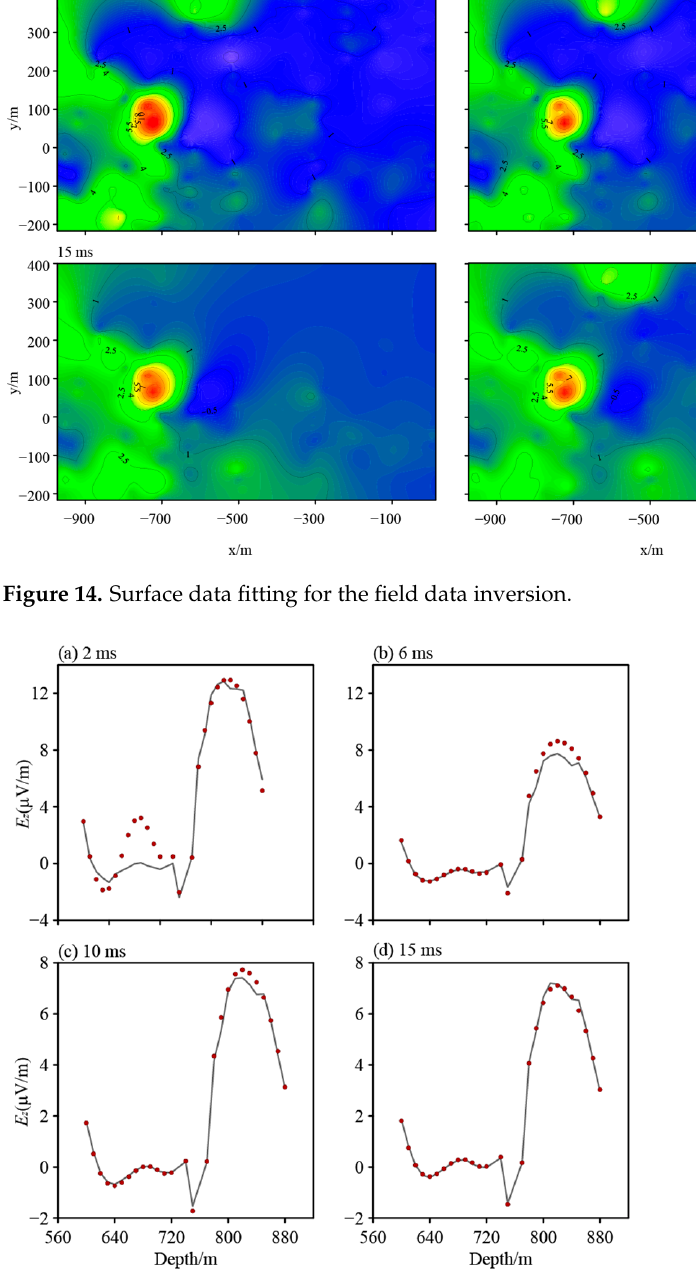
Figure 15. Borehole data fi tt ing for the fi eld data inversion.